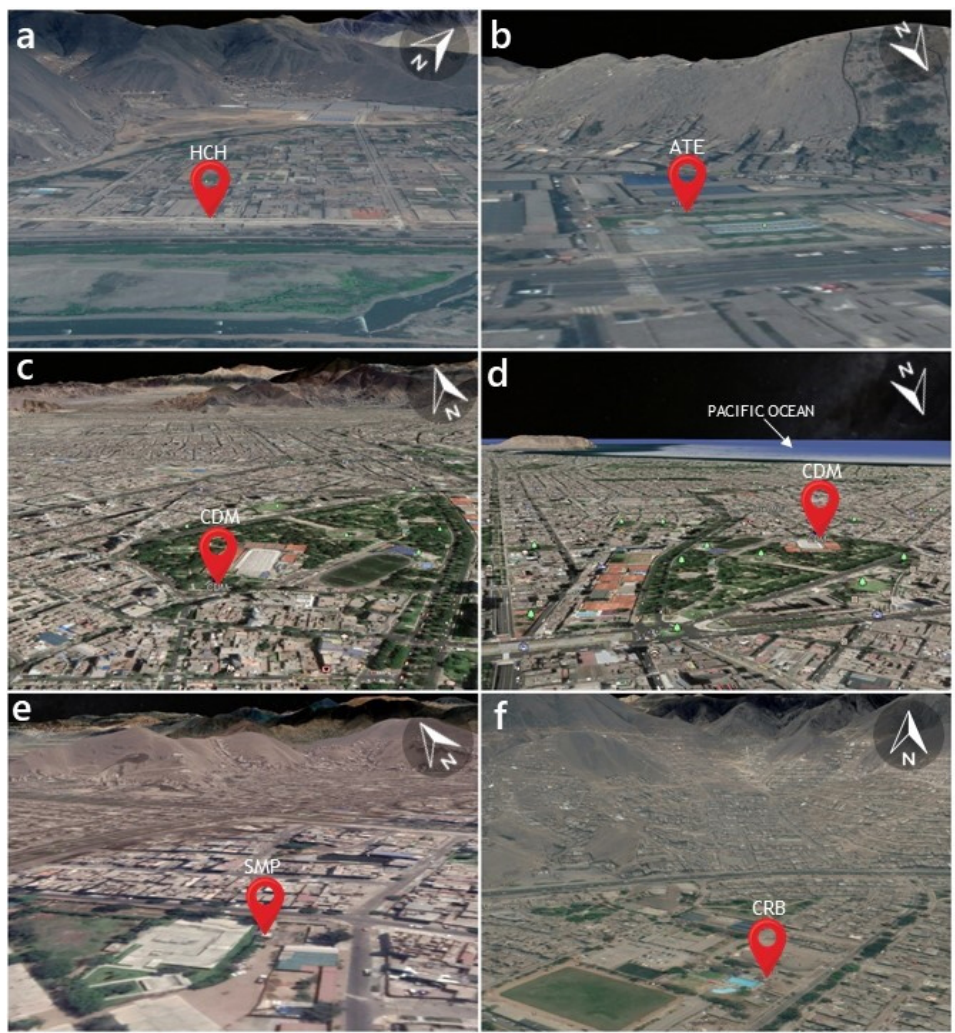
Figure A1. Satellite view of the monitoring stations ( a ) HCH, ( b ) ATE, ( c ) CDM, ( d ) CDM overlooking the Pacific Ocean, ( e ) SMP and ( f )